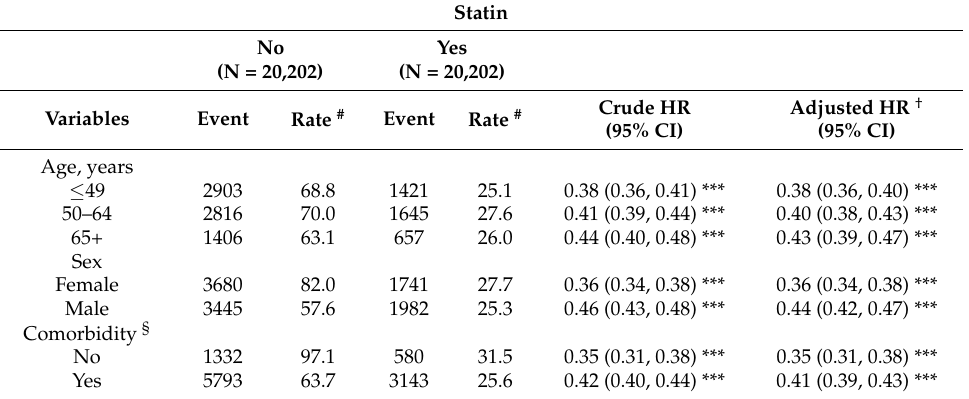
Table 3. Incidence and HRs of viral infection by age group and sex in patients with